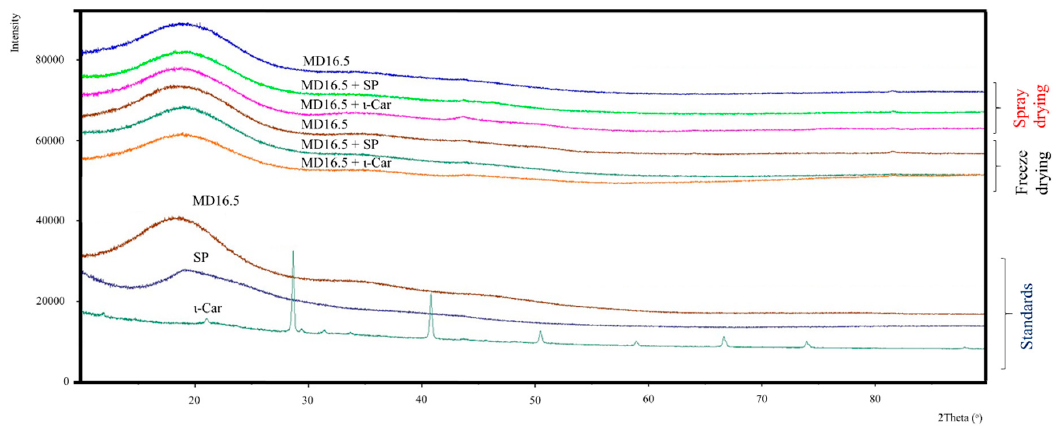
Figure 4. X-ray diffractograms (XRD) for the lemon by-product aqueous extracts encapsulated by